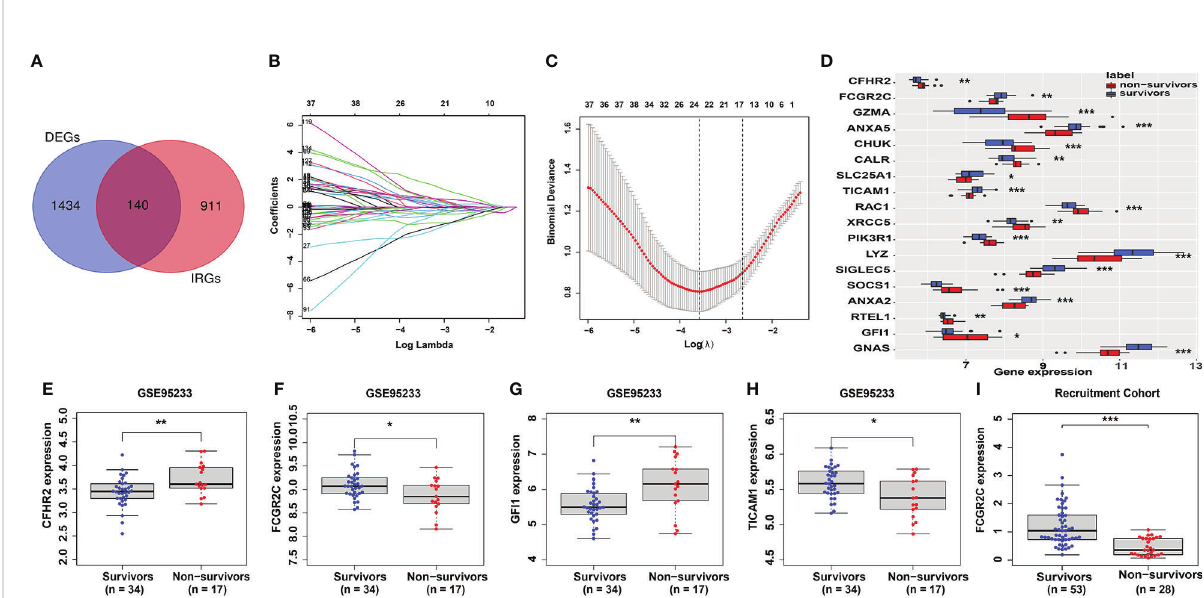
FIGURE 2 Identi fi cation and veri fi cation of prognostic genes. (A) The intersecting genes of DEGs and IRGs. (B, C) The Lasso coef fi cient values of 18 candidate prognostic genes were identi fi ed from the intersected genes in the discovery dataset. The vertical dashed lines are at the optimal log ( l ) value. (D) The 18 candidate prognostic genes are shown in the box plot. (E – H) Identi fi cation of prognostic genes in the fi rst validation cohort (GSE95233). Only 4 genes (CFHR2 (E) , FCGR2C (F) , GFI1 (G) , and TICAM1 (H) ) had the same expression differences as those in the discovery cohort. (I) Veri fi cation of FCGR2C in the second validation cohort (our recruitment cohort). The expression difference of FCGR2C was the same as that in the discovery and fi rst validation cohorts. (*:P< 0.05, **:P< 0.01, ***:P <